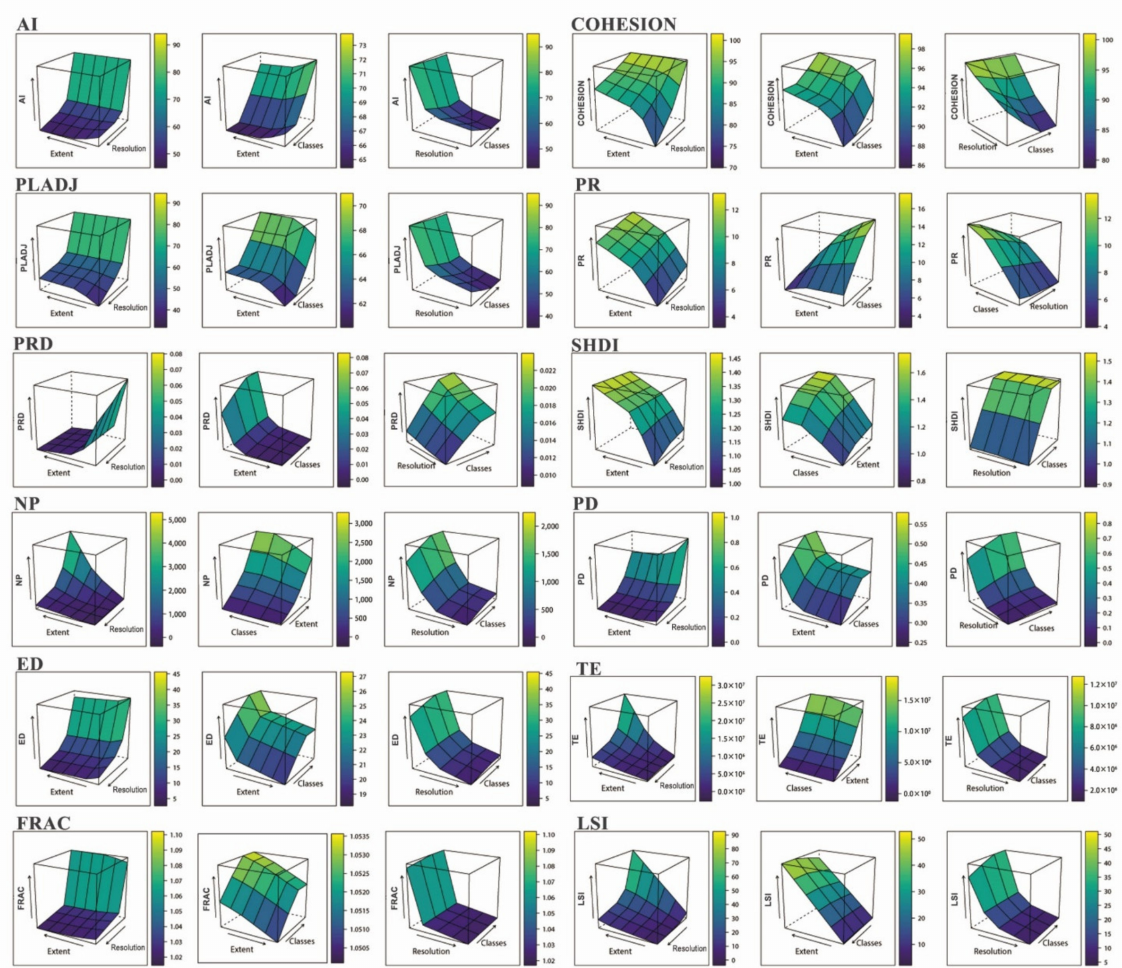
Figure 5. The two-scale interaction scaling surfaces of 12 landscape metrics. The arrow is the direction from a small value to a large